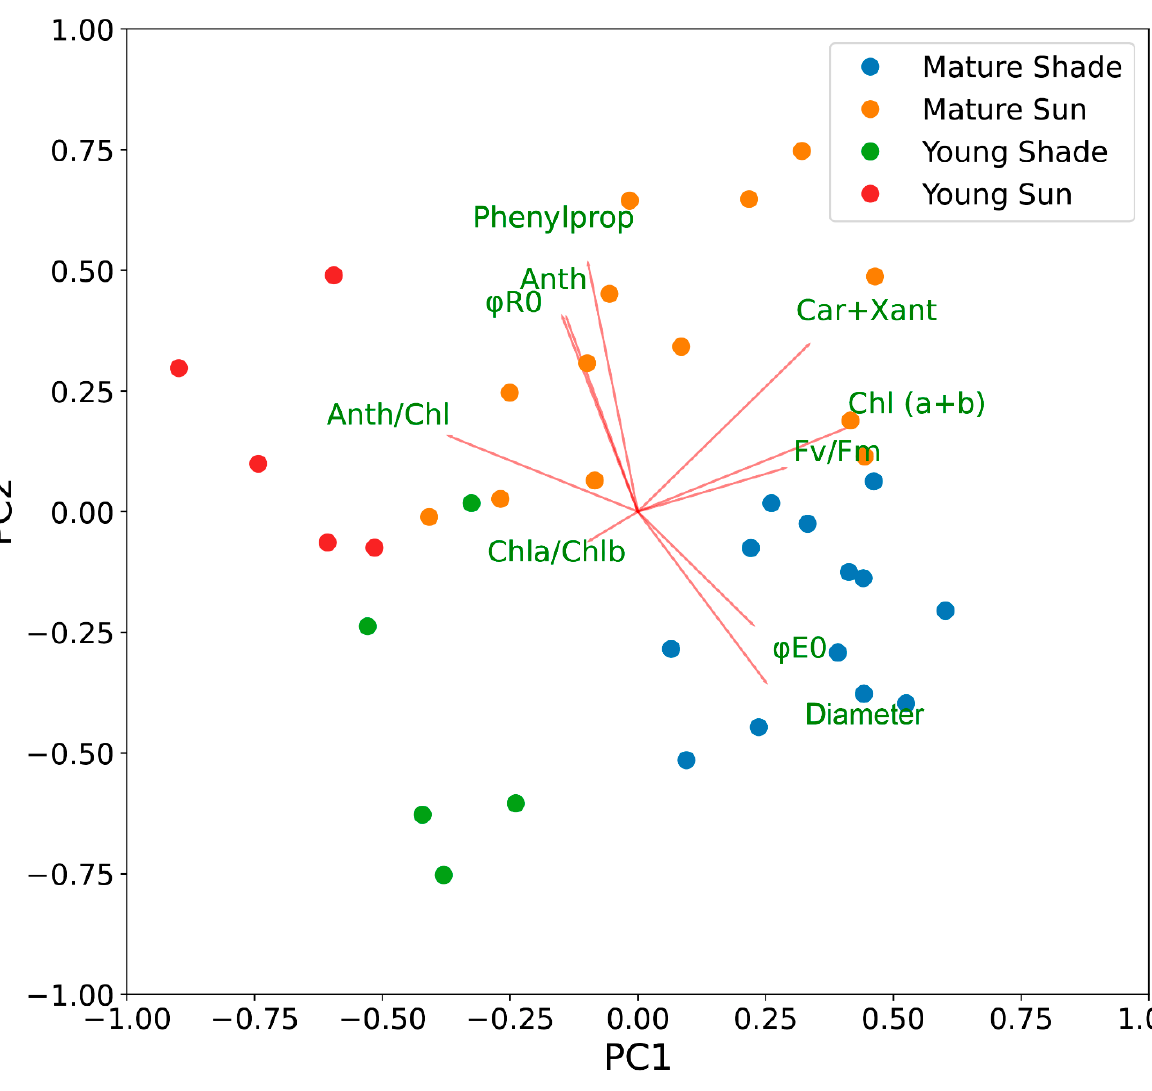
11 of 20 Figure 8. Relationship between digital values of leaf color G/B (a ratio of mean values of green to blue) and chlorophylls ( a ), anthocyanins ( b ) and ratio of chlorophylls to anthocyanins ( c ) in young and mature leaves of Hydrocharis morsus-ranae grown in the shade and sun. 2.7. Principal Component Analysis of the Variability of Photosynthetic Traits With principal components analysis (PCA) it was found that the first principal